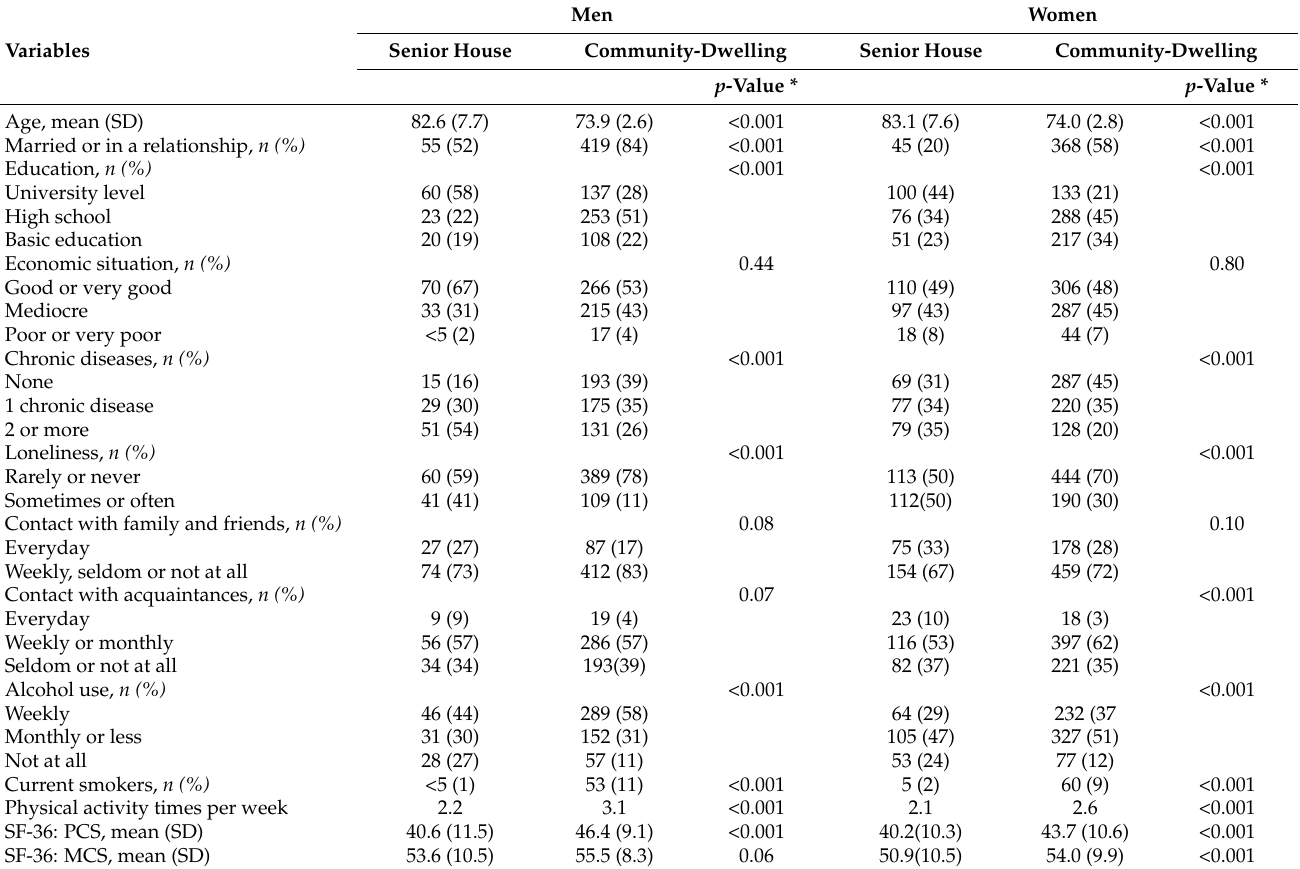
Table 1. Participants’ demographic and socioeconomic